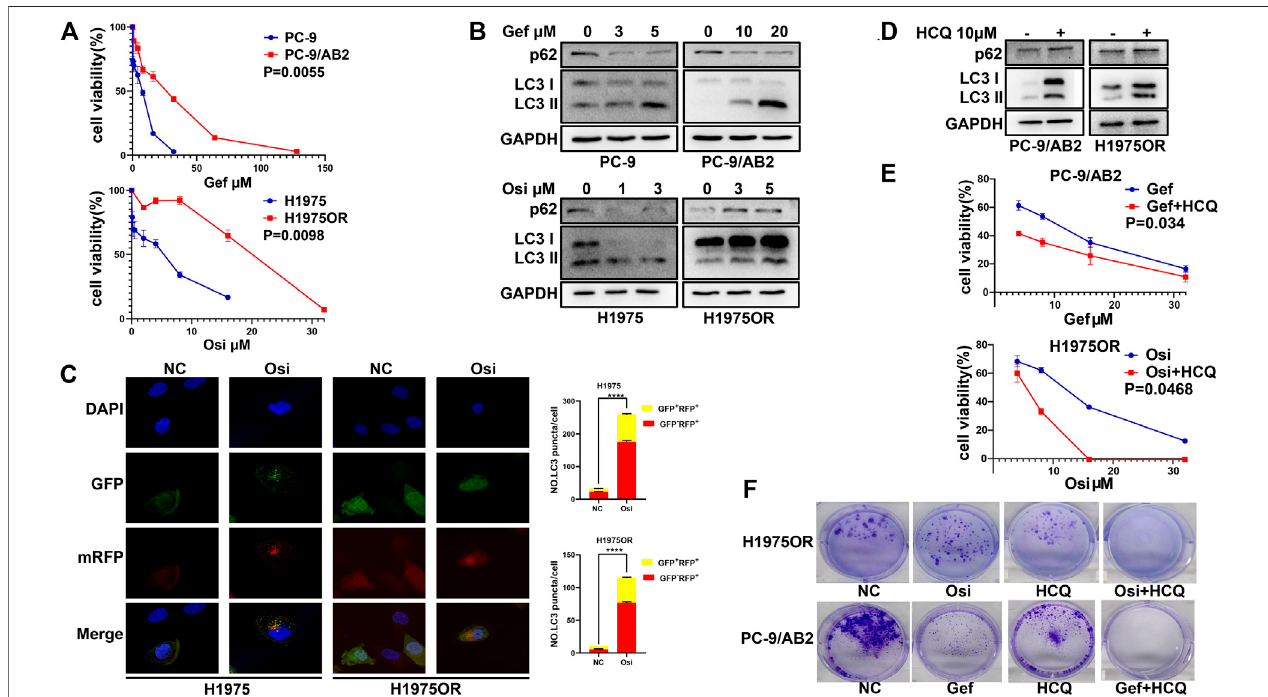
FIGURE 1 | EGFR-TKIs induced protective autophagy in NSCLC cells. (A) The CCK-8 method was used to detect parental PC-9 and H1975 cells and their corresponding drug-resistant cells, and the concentration of ge fi tinib or osimertinib was increased and treated for 48 h. Three replicates were used for the experiments, and data are presented as mean ± SEM. (B) EGFR-TKIs treatment decreased p62 protein levels and increased LC3-II accumulation in PC-9/H1975 and corresponding drug-resistant cells. (C) Fluorescence assay showing representative images of cells transfected with GFP-RFP-LC3 double-labeled adenovirus. Autophagic fl ux was signi fi cantly increased in H1975 and H1975OR after 1 μ M osimertinib treatment for 48 h. Quantitative analysis of the number of yellow autophagosomes and red autolysosomes. **** p < 0.0001. (D) 10 μ M HCQ can inhibit the autophagy level of drug-resistant cells. (E) CCK-8 assay suggested that the inhibitory effect on drug- resistant cells was signi fi cantly enhanced after EGFR-TKIs combined with 10 μ M HCQ compared with single EGFR-TKI treatment. Three replicates were used for the experiments,andthedataarepresentedasmean±SEM. (F) Thecolonyformationassaysuggestedthatthenumberofcoloniesinthetwo-drugcombinationgroupwas signi fi cantlylowerthanthatinthesingle-druggroup.NC:DMSO,Gef:1 μ Mge fi tinib,Osi:1 μ Mosimertinib,HCQ:10 μ MHCQ,Gef+HCQ:1 μ Mge fi tinib+10 μ MHCQ, Osi + HCQ: 1 μ M osimertinib + 10 μ M